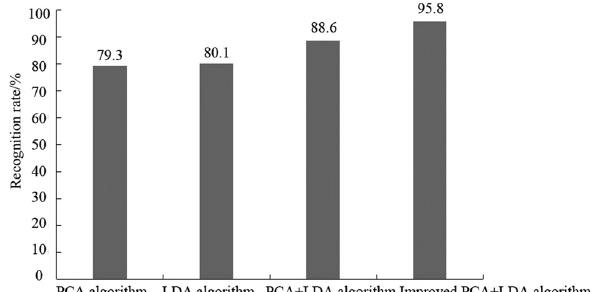
Figure 2: Comparison of recognition rate between